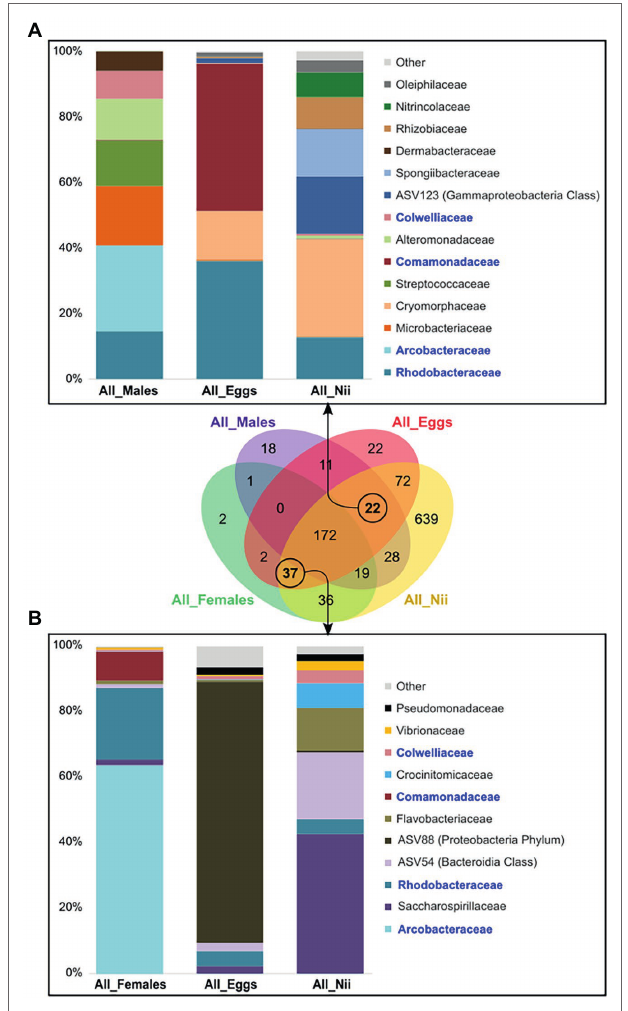
FIGURE 5 | Shared bacterial lineages among the eggs, the nauplii, and the breeders. Top bacterial families with a total relative abundance higher than 1% shared among (A) the male, the egg and the nauplius (nii) samples (22 ASVs) and (B) the female, the egg and the nauplius (nii) samples (37 ASVs). The bacterial families in blue are the bacterial families shared between the two histograms which were constructed by averaging the triplicates for each sample